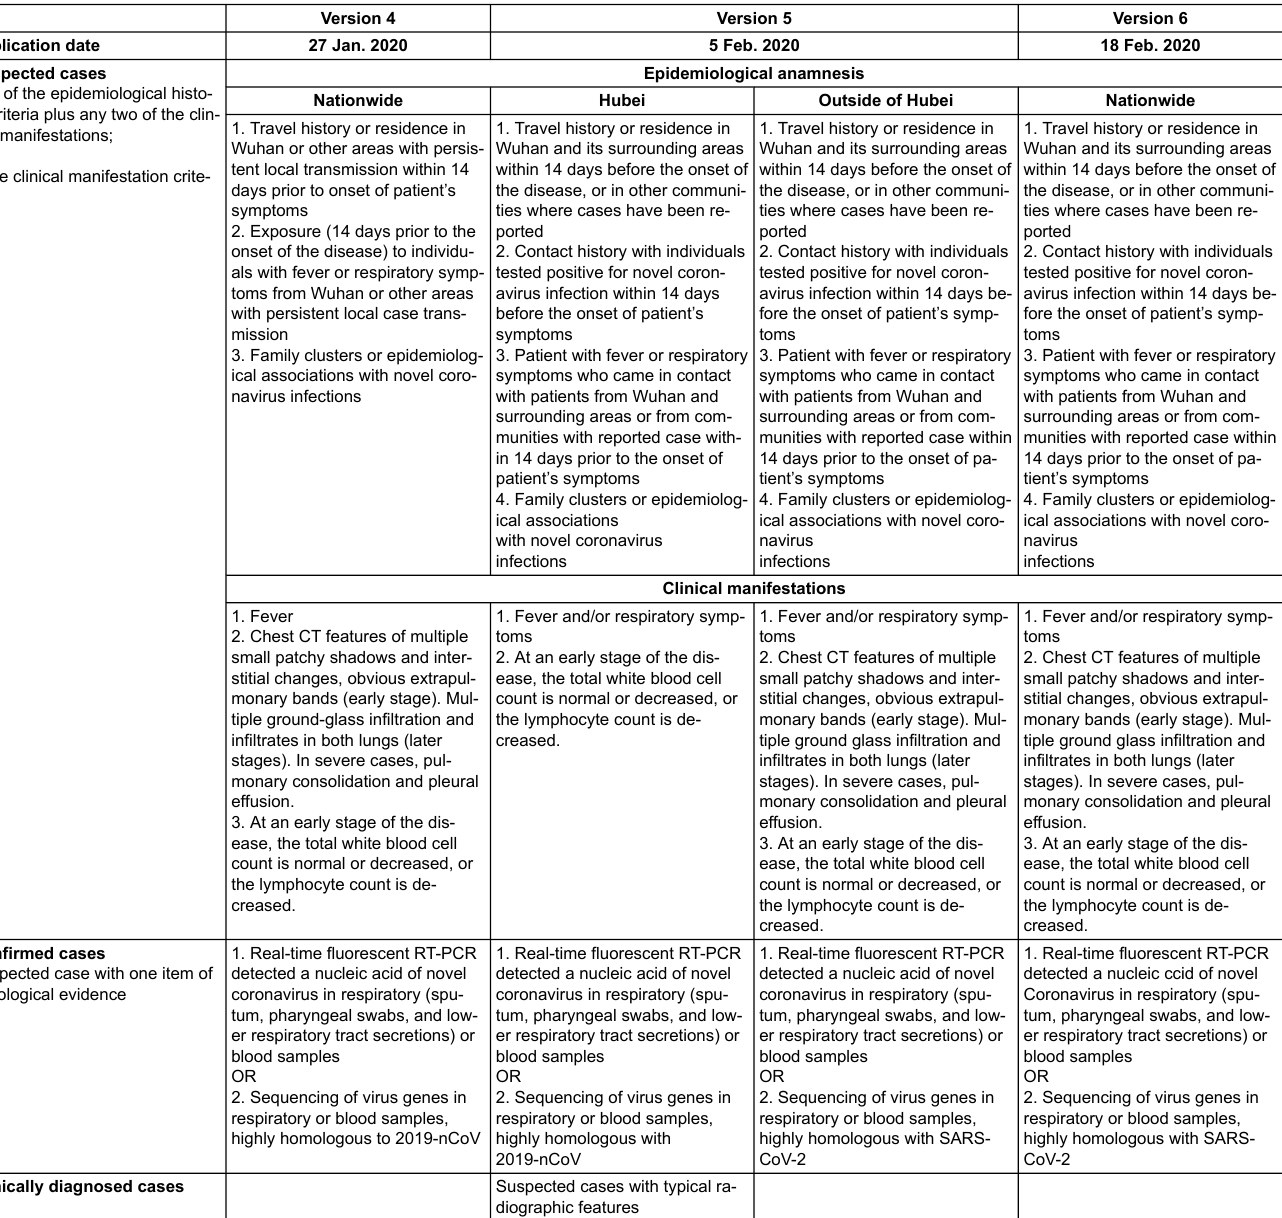
Table 1: Diagnostic criteria for COVID-19 infection – development of version 4 to version 6. Version 5 implemented clinically diagnosed cases for Hubei province.